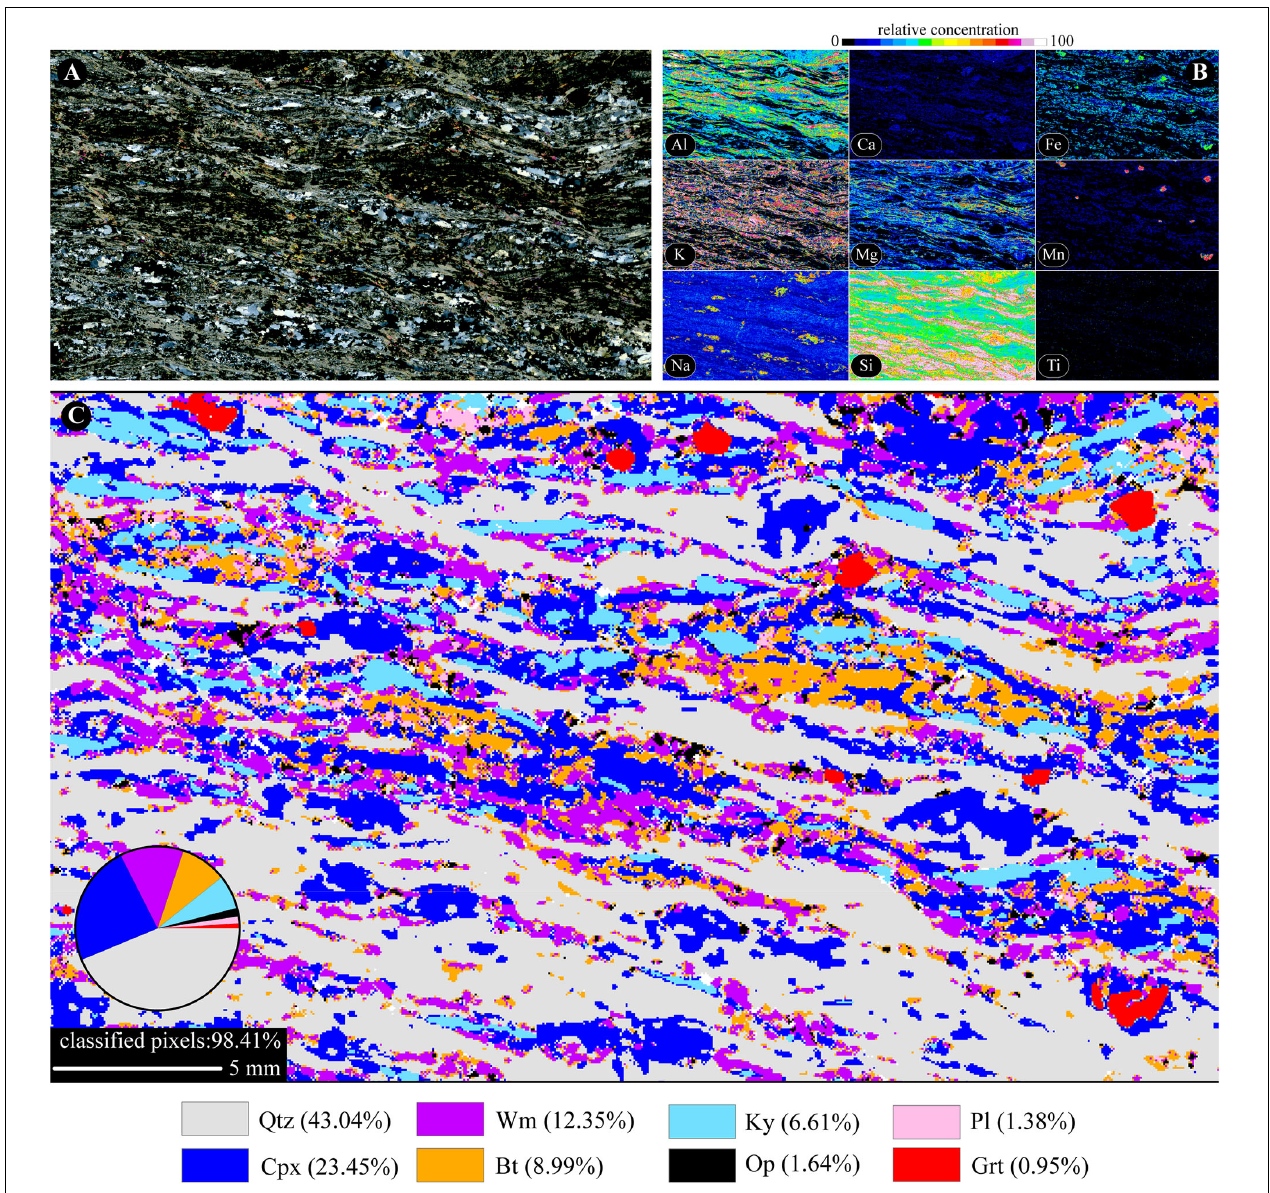
FIGURE 4 | (A) High-resolution optical scan of entire thin section characterized by well-developed pre-S1 foliation, crossed polars. (B) X-Ray maps of entire thin section (i.e., Al, Ca, Fe, K, Mg, Mn, Na, Si, and Ti). (C) Results of Q-XRMA first cycle classification and mineral modal percentage.